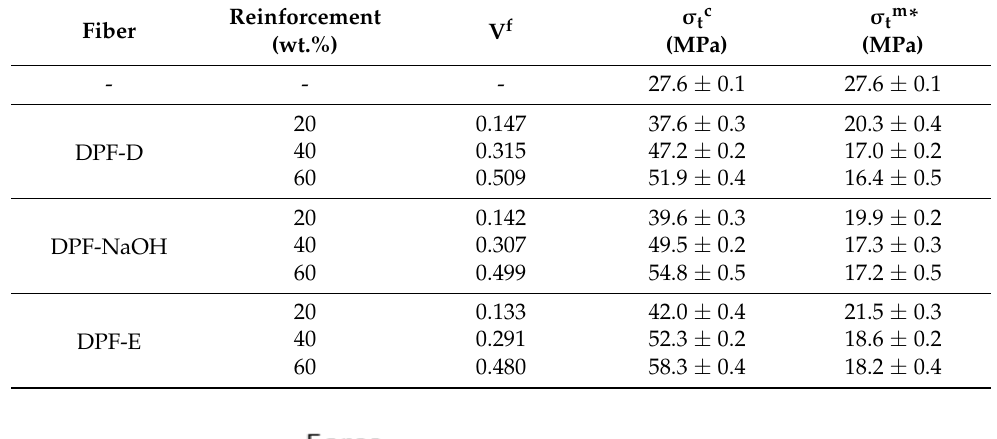
Table 4. Tensile strength of composite and matrix contribution to the tensile strength of date palm fiber composites.